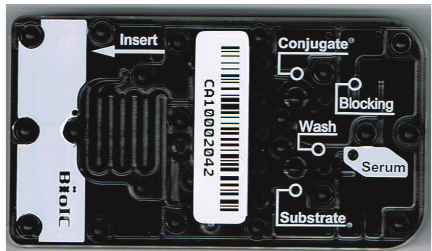
Figure 1: A figure of the microfluidic chip. After adding buffers to each well, the chip then went through the automatic process in a reaction chamber. The entire process was about 1 hour and then the chip can be taken out to the analyzer for determining the amount of IFN- 𝛾 and IL-10.